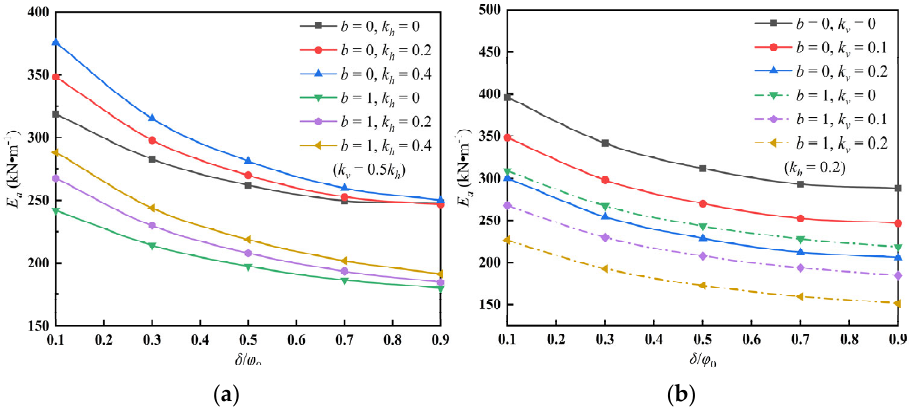
Figure 8. Influence of δ and k h , k v on E a : ( a ) δ − E a and k h − E a ; ( b ) δ − E a and k v − E a